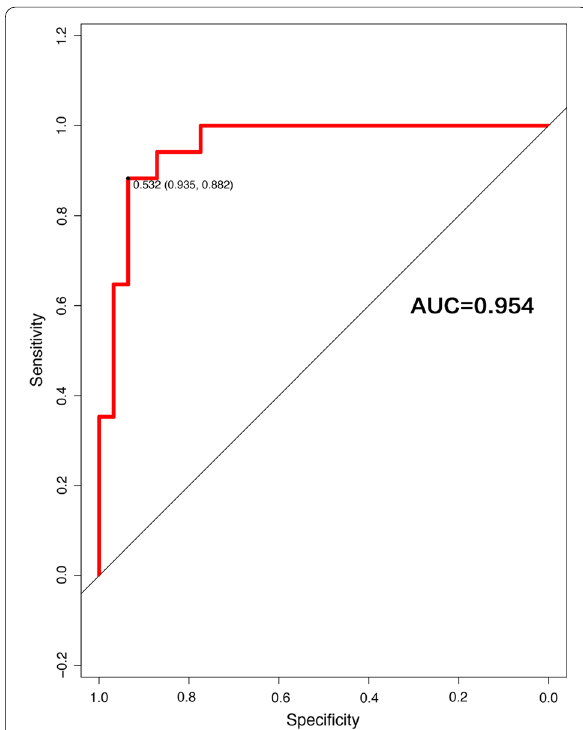
Fig. 5 ROC curve of validation group. Non-LAA non‑large artery atherosclerosis, AIS acute ischemic stroke, CK-MB creatine